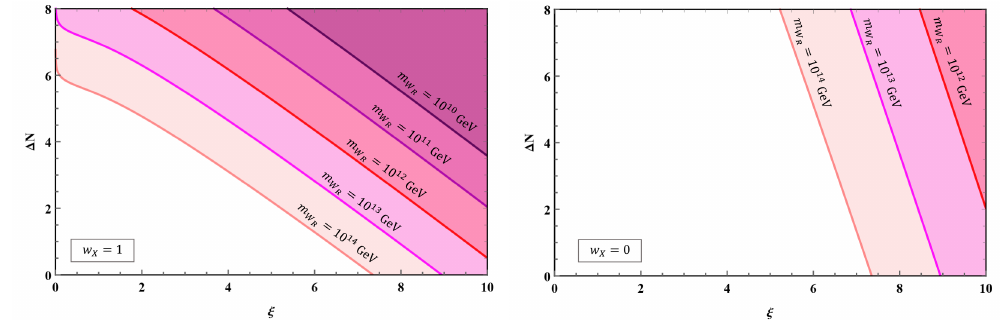
Figure 10 . Condition restricted C2 in type- I scenarios. The shaded area above each line corre- sponds to the accessible parameter space for a given m that satisfies eq. (4.13). The left and W R right panels show w = 1 and w = 0 respectively. The Max of m is set to be 10 − 2 GUT X X WR